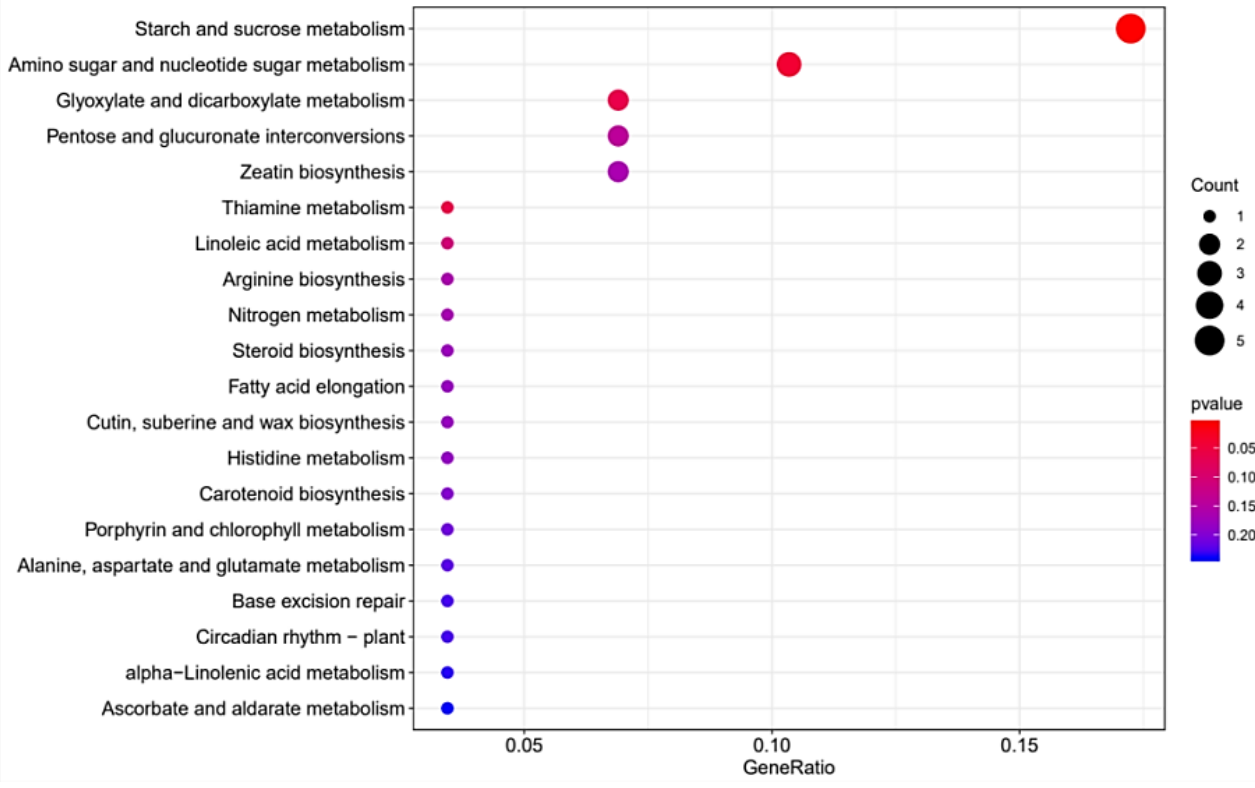
Figure 9. The enriched KEGG pathway of differentially expressed genes.